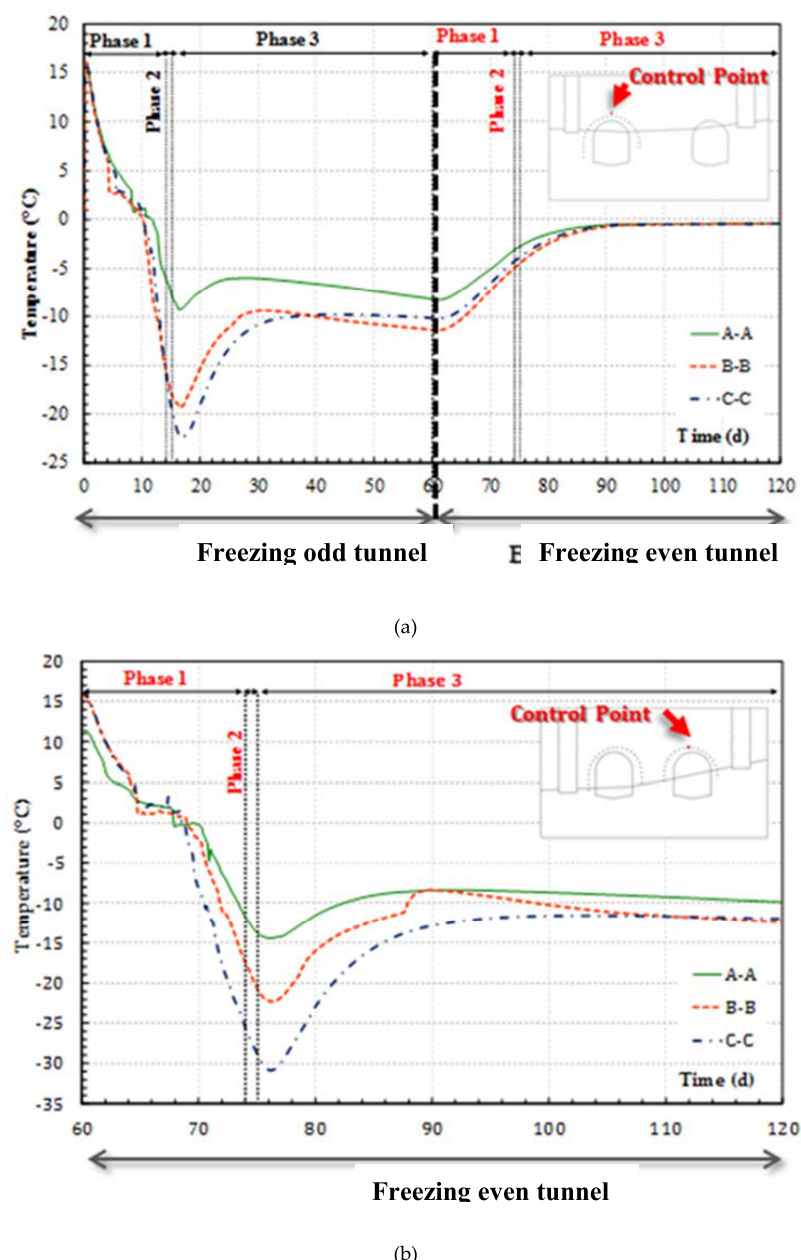
Figure 16. ( a ) Temperature profiles at the control point on the top of the odd tunnel for the three sections; ( b ) Temperature profiles at the control point on the top of the even tunnel for the three